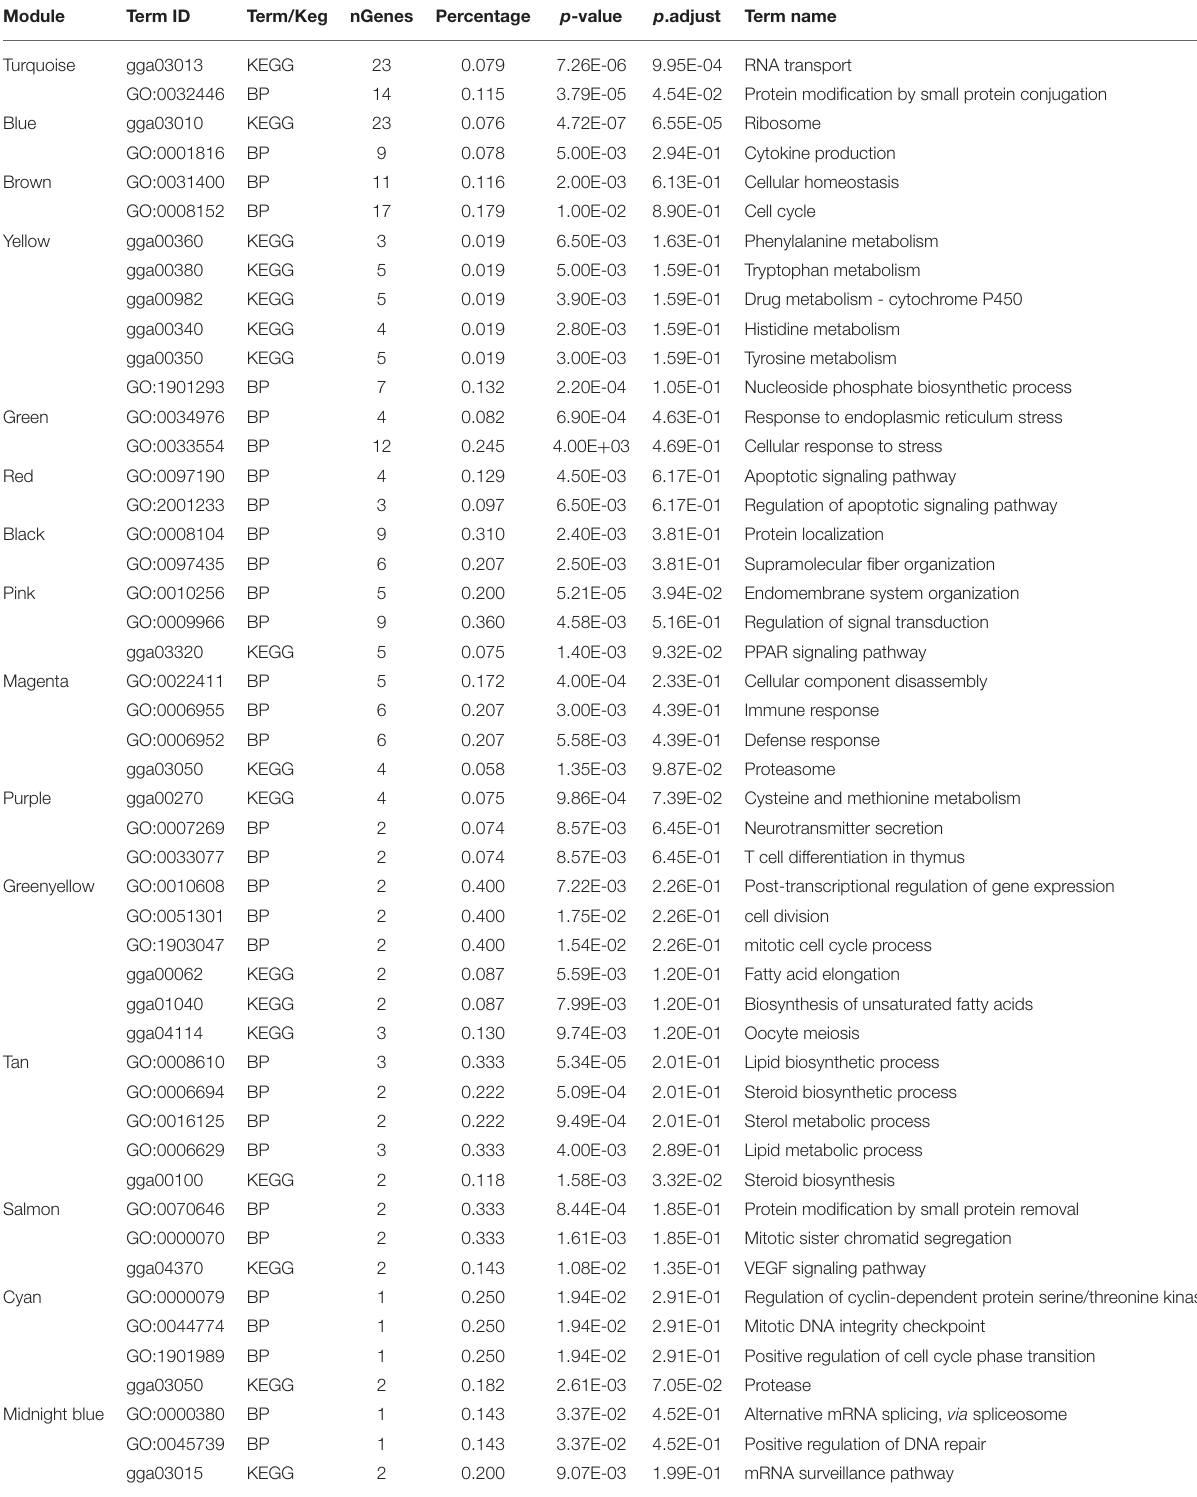
TABLE 1 | Gene ontology (GO) and KEGG pathway functional annotation of genes in the gene coexpression network. Module Term ID Term/Keg nGenes Percentage p -value p .adjust Term name